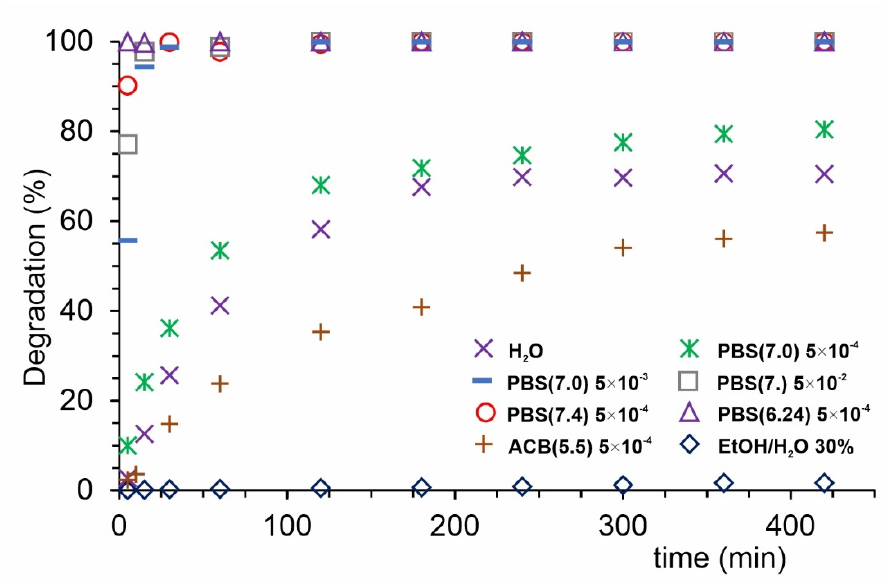
Figure 1. PPF degradation kinetics in various solutions.